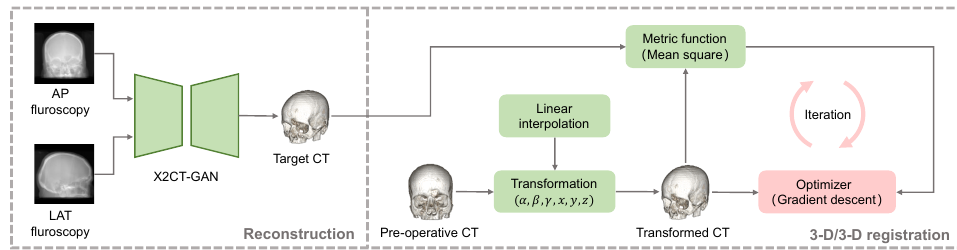
Figure 1. The framework of the proposed method: In the reconstruction stage, two orthogonal views of fluoroscopy images are input into the X2CT-GAN to reconstruct the target CT image. In the 3- D/3-D registration stage, the pre-operative CT is aligned with the target CT using a GPU-accelerated optimization framework. Green patches in the illustration denote parts implemented by GPU, and red patch denotes the part run on